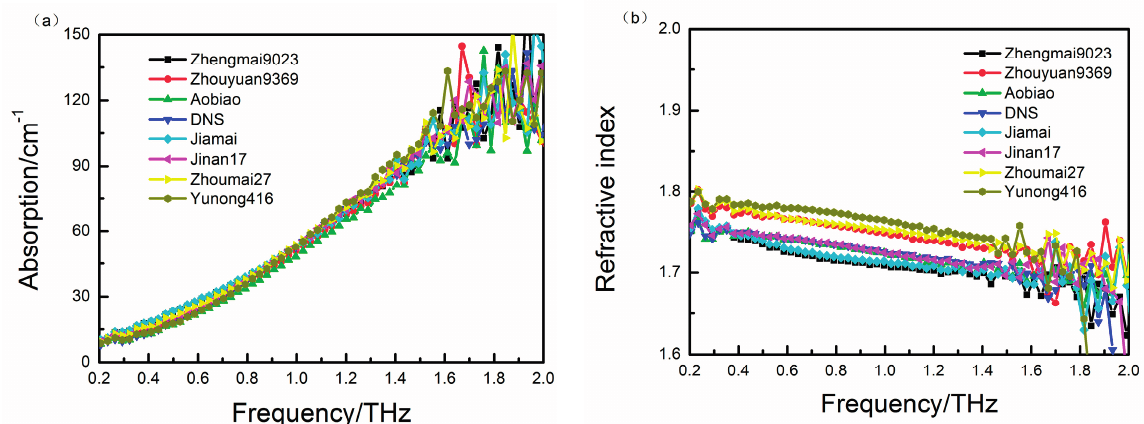
Figure 2. ( a ) The absorption coefficient and ( b ) refractive index for the eight wheat samples in the range of 0.2–2.0